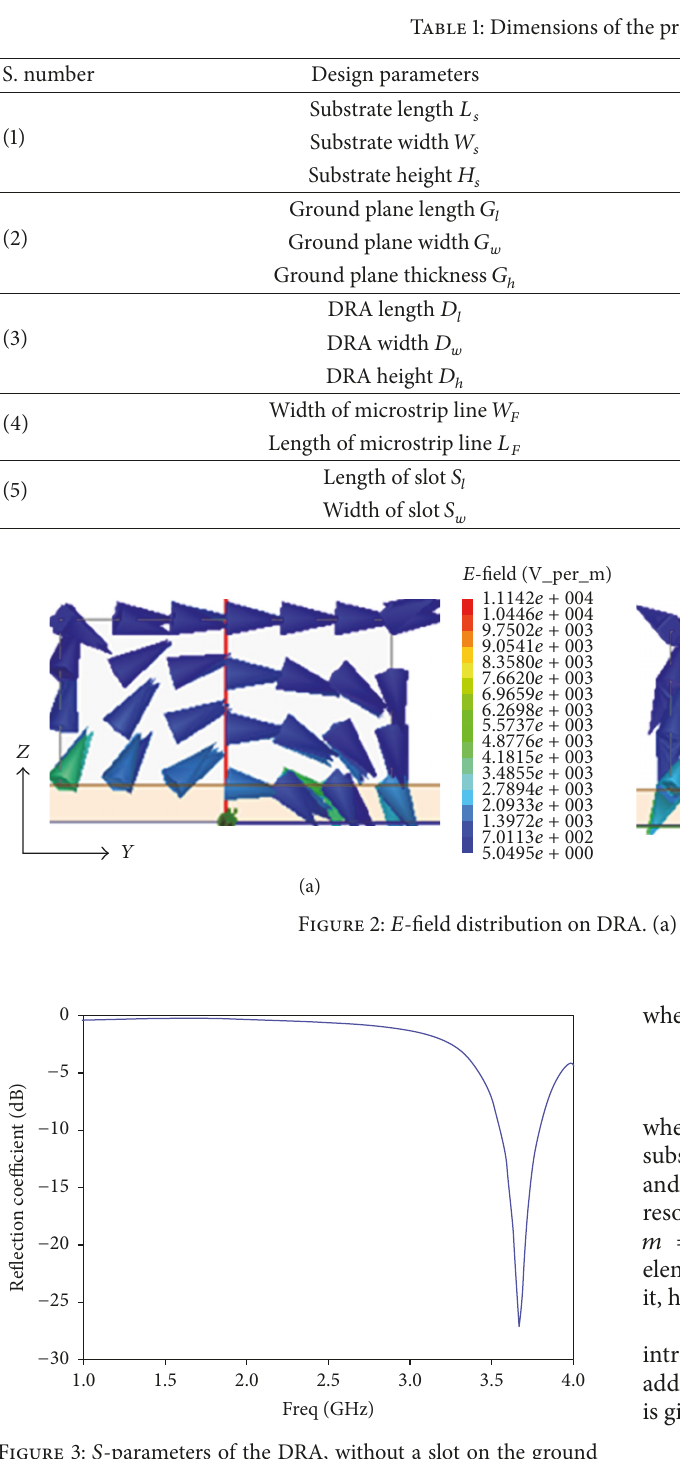
Figure 3: 𝑆 -parameters of the DRA, without a slot on the ground